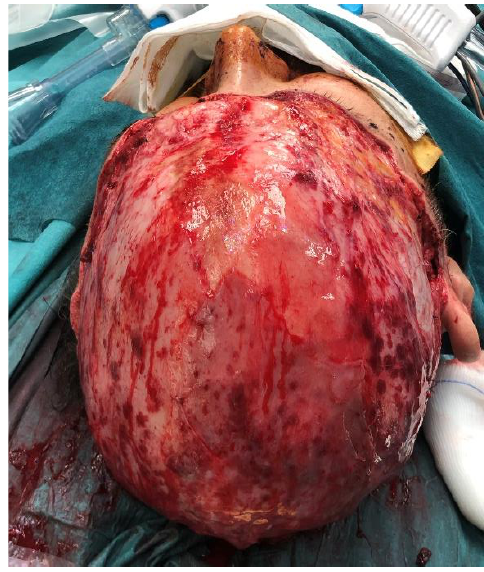
Figure 2. Wound surface after debridement.